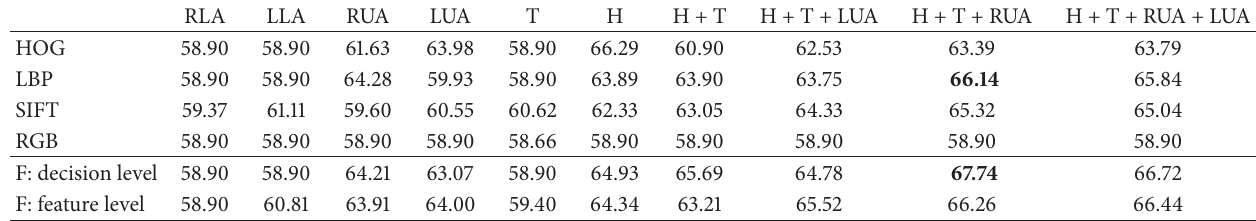
Table 4: Automated gender recognition accuracies (%) on